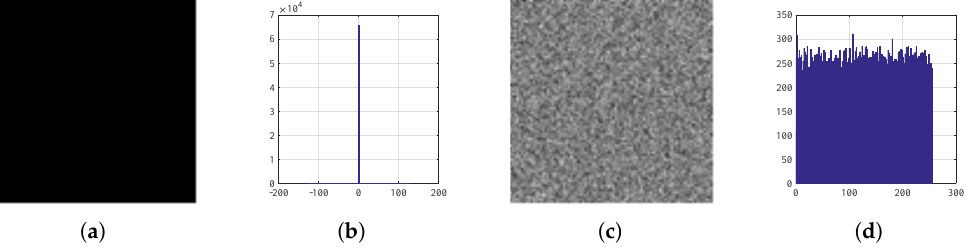
Figure 8. Histograms: ( a ) Black image, ( b ) histogram of plain Black, ( c ) encrypted Black, and ( d ) histogram of encrypted Black.